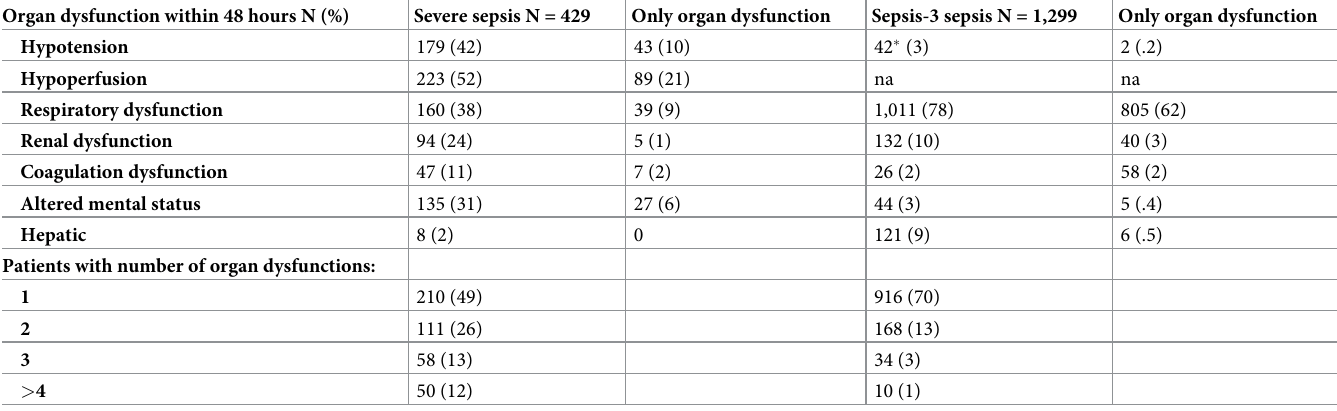
Table 4. Occurrence of organ dysfunction at first admission in 2,072 consecutive adult patients with community onset infection. Organ dysfunction within 48 hours N